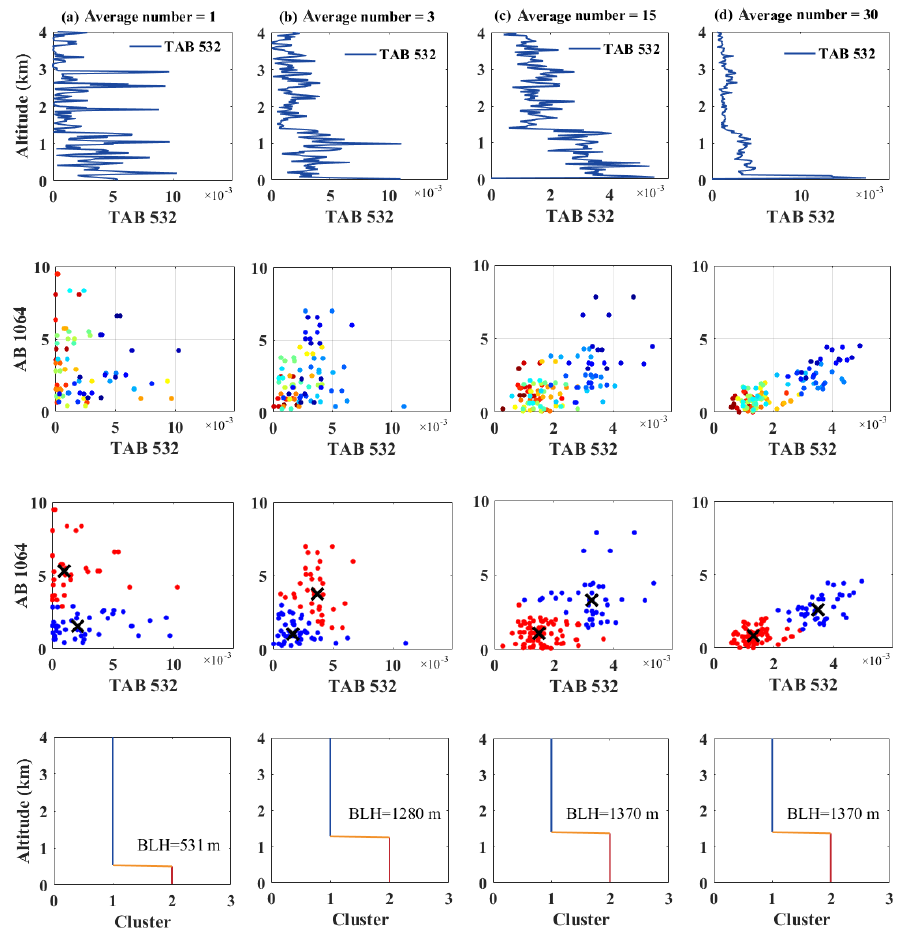
Figure 6. Case study of CALIPSO data with different horizontal smoothing numbers on 12 February 2015 over Wuhan area. (a) Average number = 1, (b) average number = 3, (c) average number = 15 and (d) average number = 30. The blue line represents the vertical profile of TAB 532 derived from CALIPSO data, the black cross represents the centroid of the cluster and the orange horizontal line represents the BLH result.